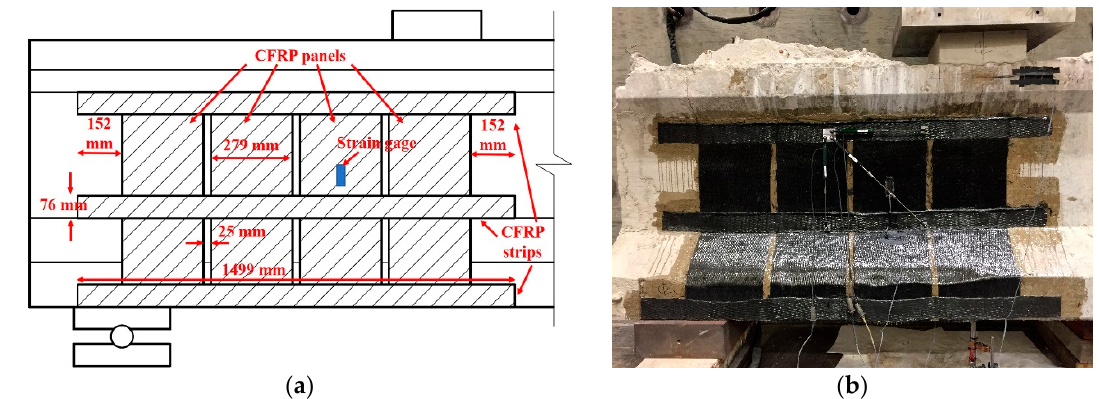
Figure 6. Carbon fiber reinforced polymer (CFRP) laminate repair design: ( a ) CFRP laminate dimensions and ( b ) CFRP test setup (1:27).